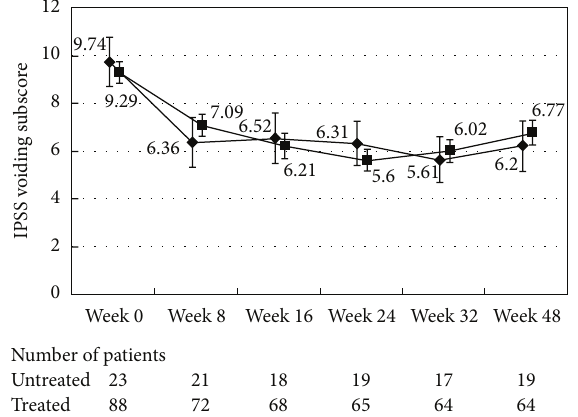
Figure 2: International Prostate Symptom Score voiding subscore (total scores of questions 1, 3, 5, and 6). The scores in the patients treated with an 𝛼 1-blocker or anticholinergic agent ( ◼ ) and the untreated patients ( ⧫ ) are shown. The values are LS mean ± SE. 𝑃 = 0.2359 (repeated